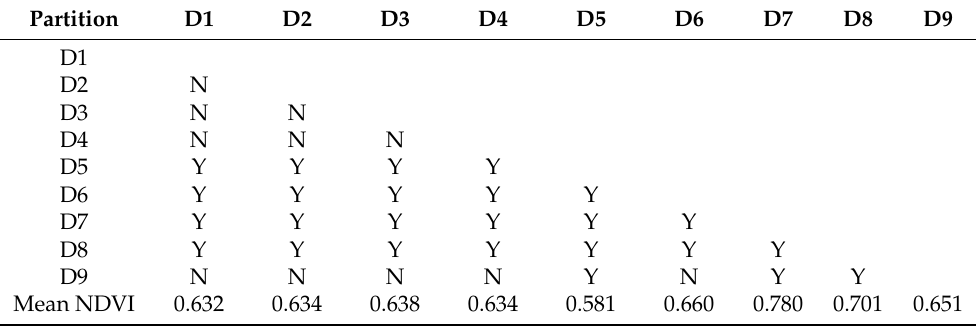
Table 10. Mean vegetation NDVI and statistical significance for every two divisions of temperature (95% confidence